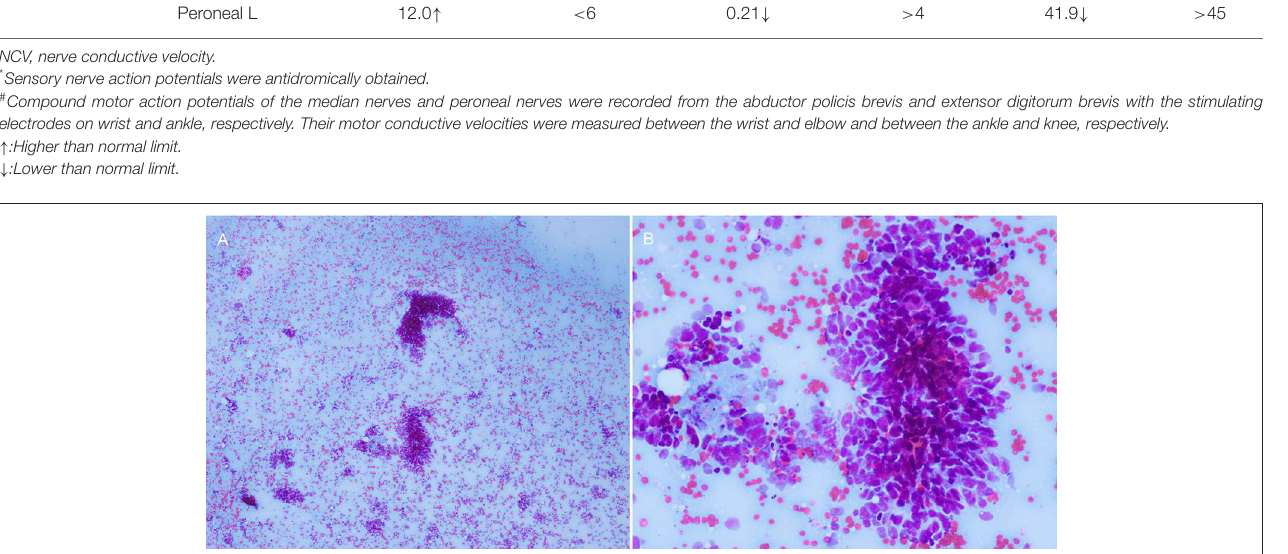
FIGURE 3 | The cytology of the mediastinal mass showed small round/oval cells with high nuclear/cytoplasmic ratio, consistent with primary SCC. (A) 40 × , (B) 100 ×